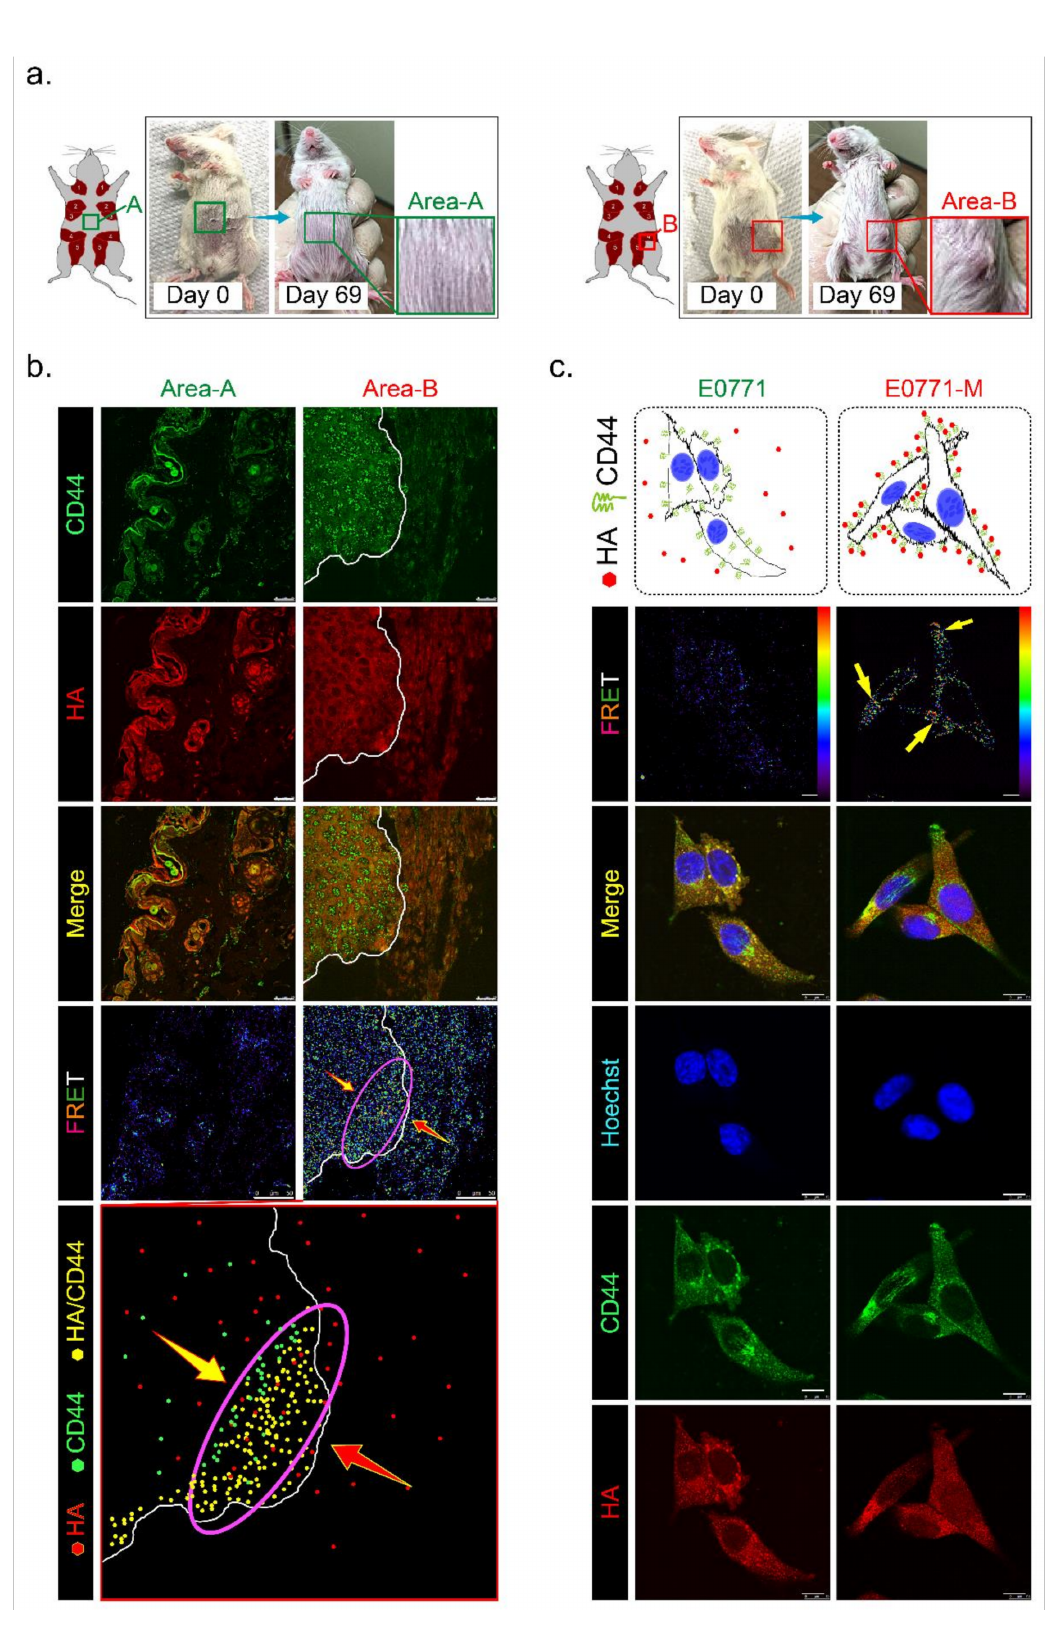
Figure 6. Has3 expression in the parenchymal tissues inhibited TNBC-PDX tumor growth in immunodeficient (NOD SCID gamma mouse, NSG) mice. ( a ) PDX (F3) mice were generated from 6 TNBC biopsies. Tumor tissues from the same patient were transplanted into the same mice in different areas (A and B, as indicated in the left panel); ( b ) The PDX tumor sections (area A and area B) were adapted for immunofluorescence staining by using antibodies specific to CD44